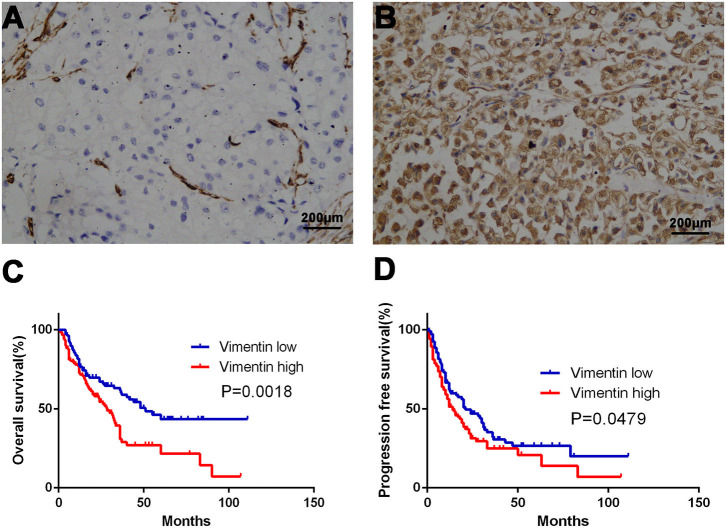
Association of vimentin expression and prognosis. Typical images of low vimentin expression (A) (negative expression in tumor cells and positive expression in endothelial cells) and high expression in tissue microarray. (B) Kaplan–Meier curve of overall survival (OS) (C) and progression-free survival (PFS) (D) according to vimentin expression. Original magnification: ×100. P-value calculated by log-rank test.